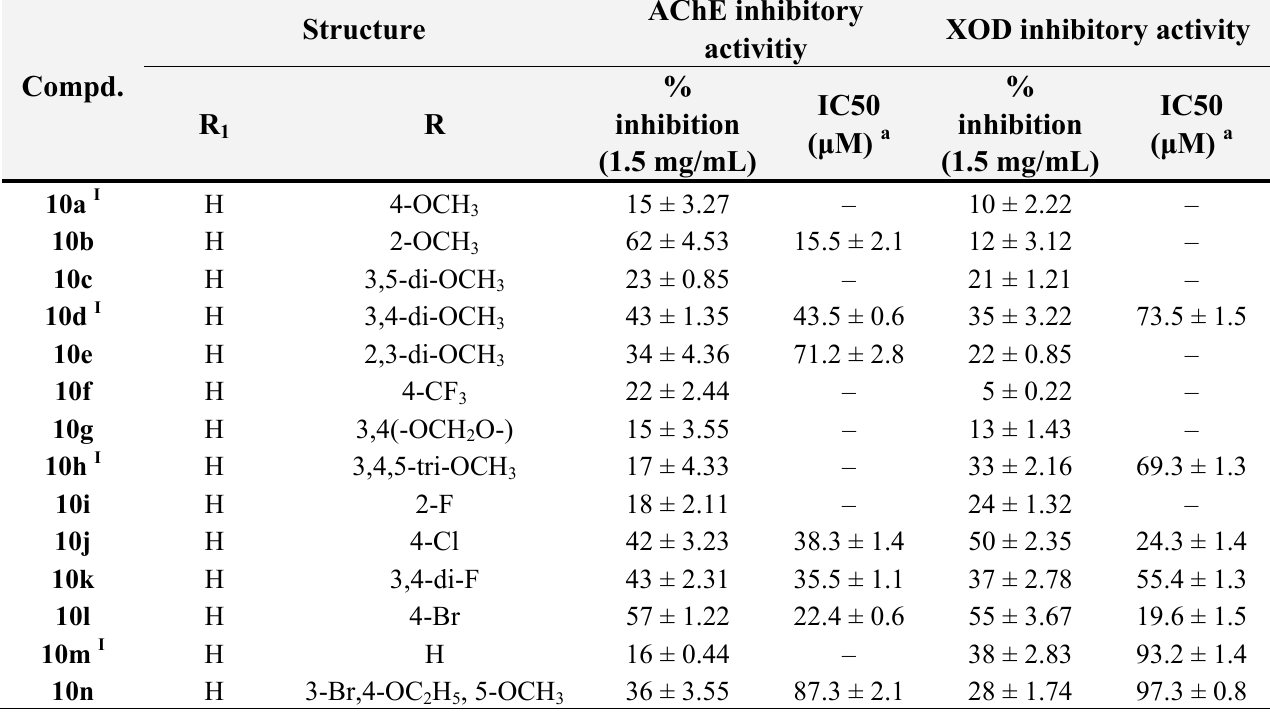
Table 1. Effect of the synthetic PPGs on acetylcholinesterase and xanthine oxidase